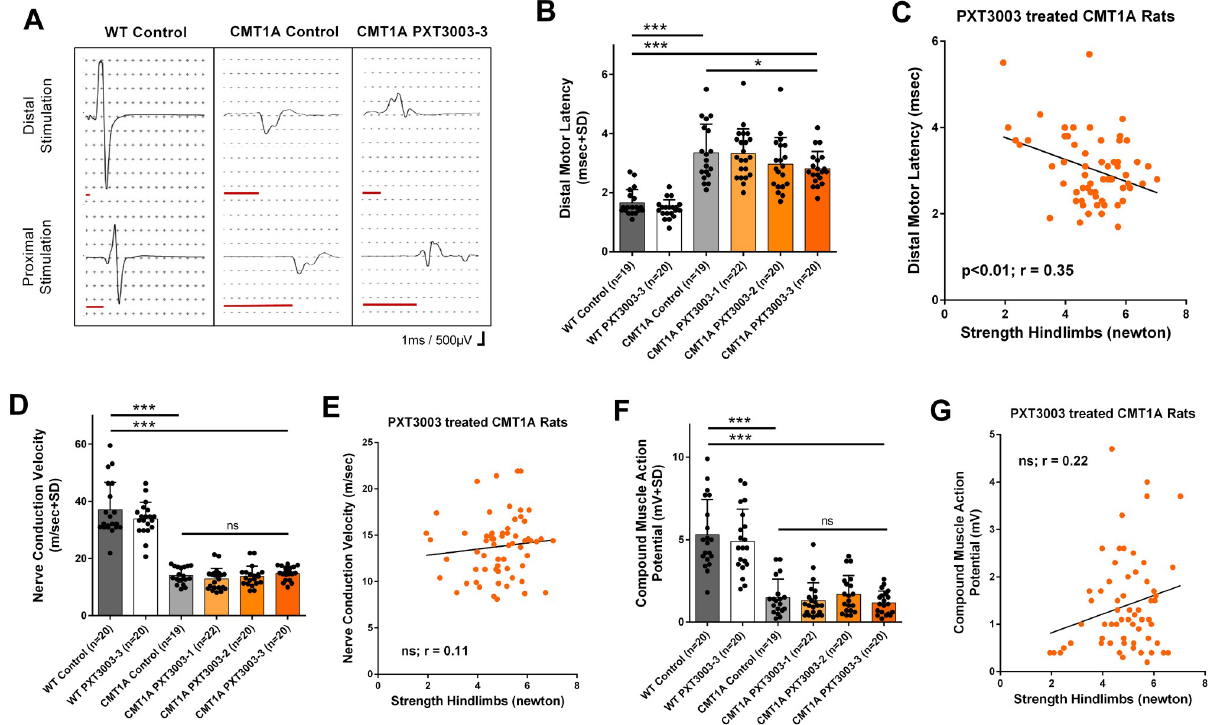
Fig 2. Improved motor latency correlating with the phenotype at study end. Electrophysiological recordings including motor latency (red bar), nerve conduction velocity (NCV) and compound muscle potential (CMAP) analysis were performed as shown for representative measures (A). CMT1A controls showed prolonged motor latencies, which were dose-dependently improved by PXT3003 early short-term treatment (B; WT controls 1.66 ± 0.10, CMT1A controls 3.35 ± 0.22, CMT PXT3003-3 2.82 ± 0.13). In long-term observation, the motor latency improvement correlated with the restored grip strength at the hindlimbs including all PXT3003 treated CMT1A rats (C). NCV and CMAP recordings were not affected by PXT3003 in long-term (D and F; WT controls 37.02 ± 2.16, CMT1A controls 14.02 ± 0,67, CMT PXT3003-3 14.86 ± 0.53 and WT controls 5.31 ± 0.47, CMT1A